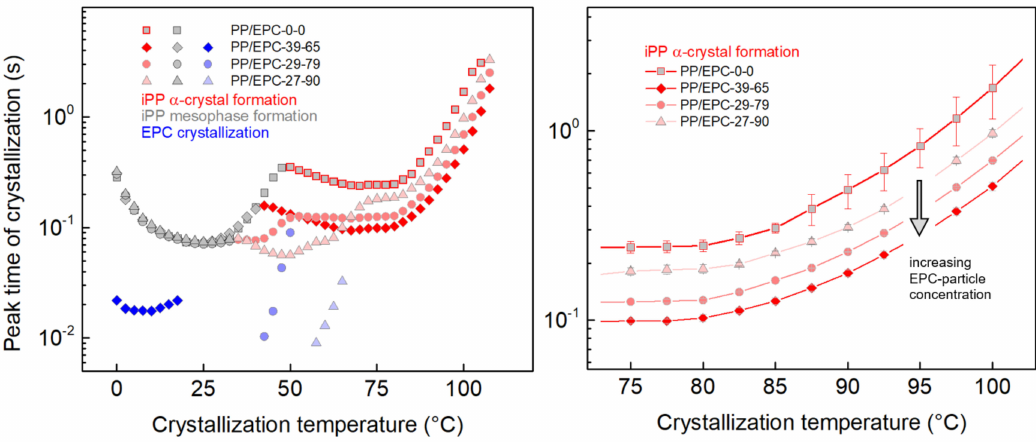
Figure 6. Peak time of crystallization of neat and heterophasic iPP as a function of the crystallization temperature in the entire analyzed temperature range between 0 and 110 ◦ C ( left ) and in the high-temperatureregionabove75 ◦ C( right ). Colorcodingofsymbols /